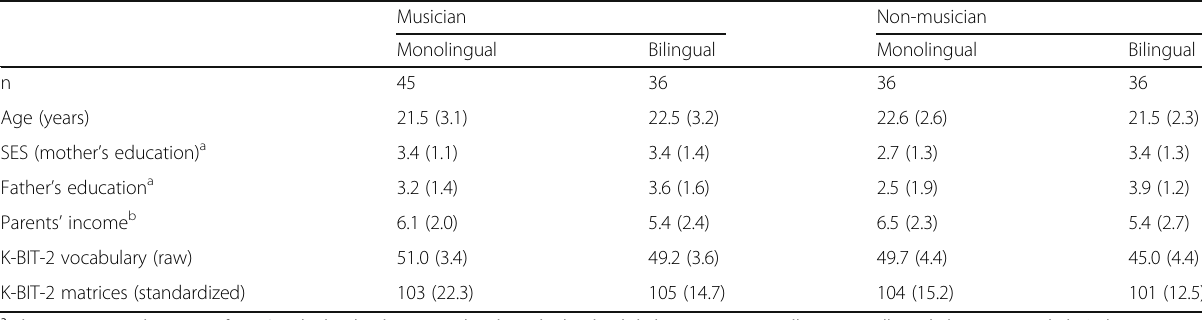
Table 1 Participant characteristics with means (SD) for each grouping